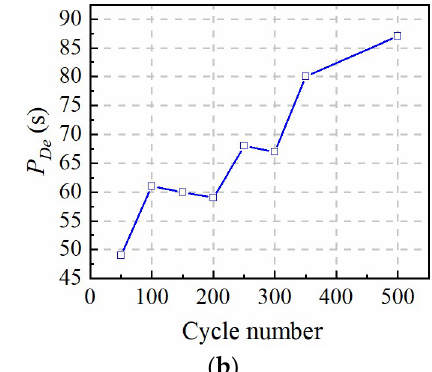
Figure 8. The identification results of health characteristic parameters of electrolyte. ( a ) Electrolyte concentration; ( b ) Liquid-phase diffusion ability.